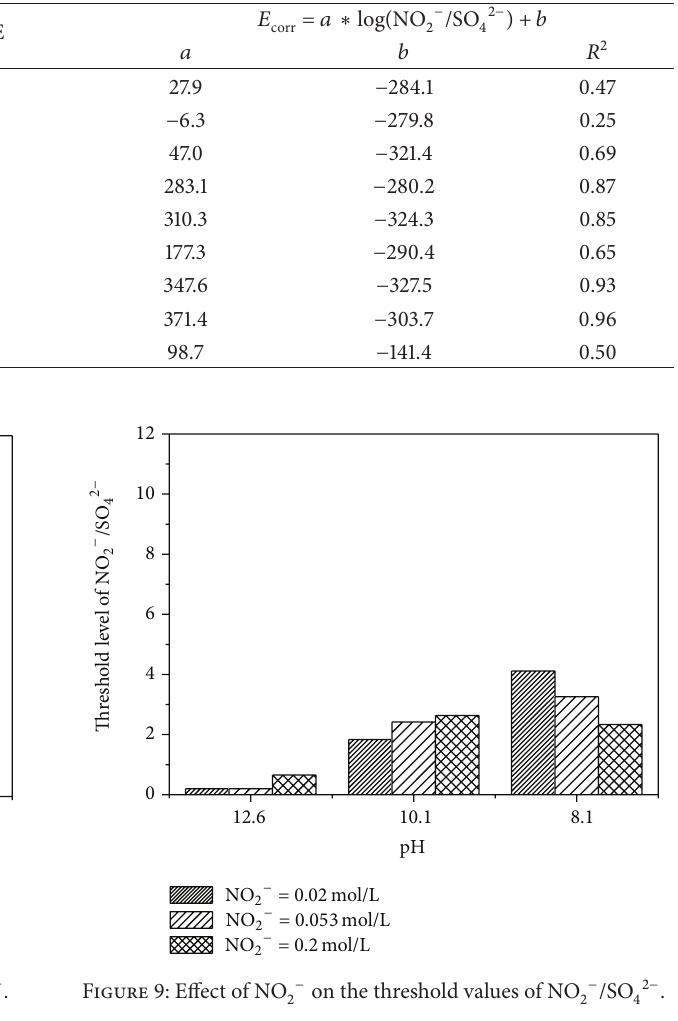
and pH on the threshold level of chloride is shown in Figure 10. In pH 12.6 environment, the chloride threshold level increased markedly when the concentration of nitrite was raised from 0 mol/L to 0.53 mol/L, while in pH 10.3